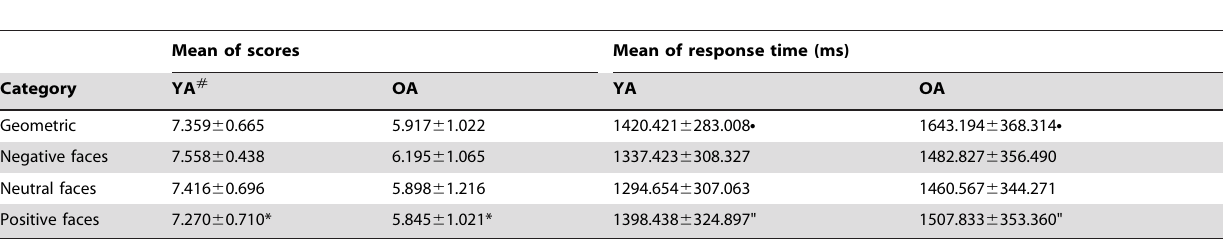
Table 2. Scores and response time of young and older adults on the SDRST according to the stimulus category.